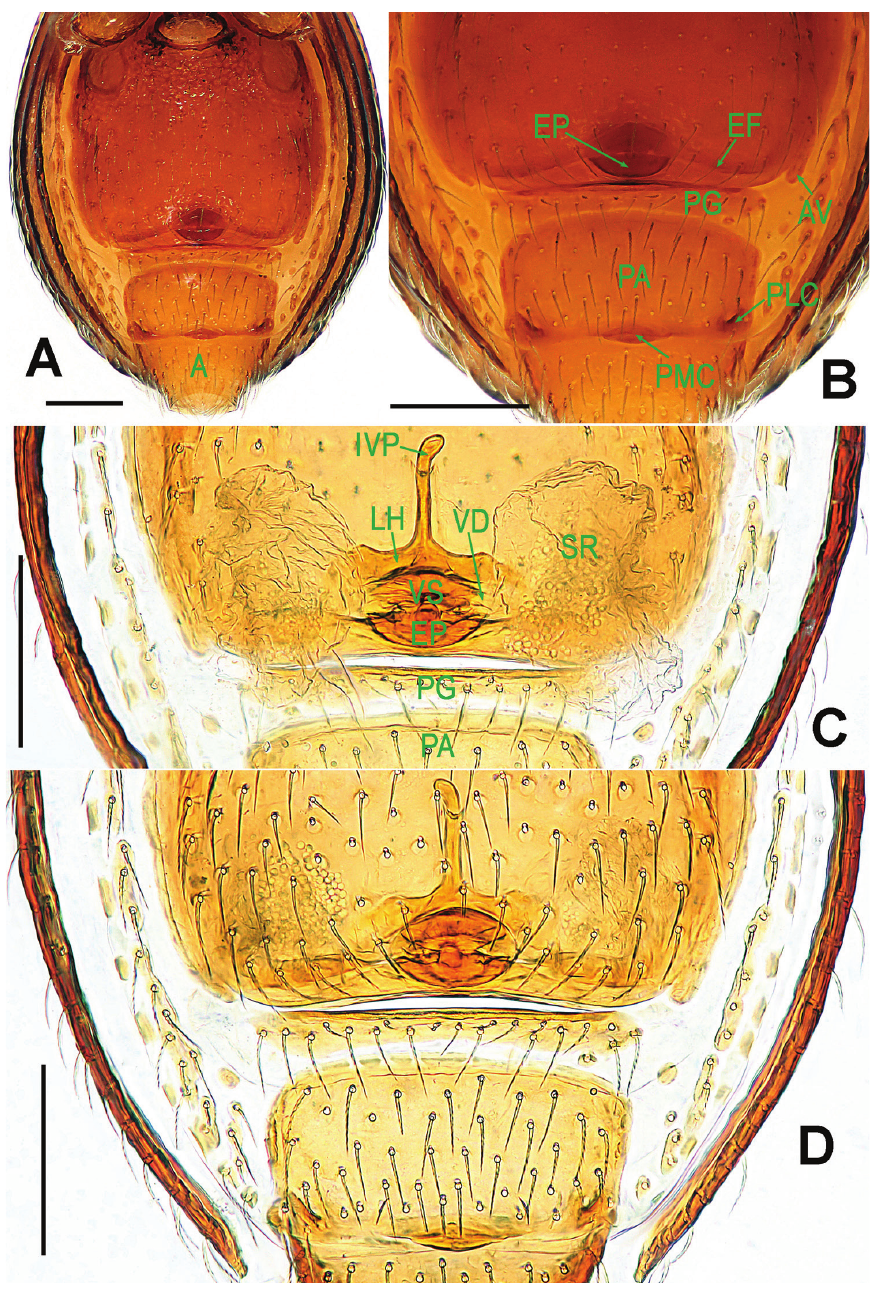
Figure 9. Ablemma malacca sp. n., female paratype. A opisthosoma B genital area (untreated) C cleared vulva (lactic acid-treated) D ditto . A–B, D ventral C dorsal. Abbreviations: A = anal plate; AV = anterior ventrolateral plate; EF = epigynal fold; EP = epigynal pit; IVP = inner vulval plate; LH = lateral horn; PA = preanal plate; PG = postgenital plate; PLC = posterolateral corner of PA; PMC = posteromedial corner of PA; SR = seminal receptaculum; VD = vulval duct; VS = vulval stem. Scale bars: 0.10